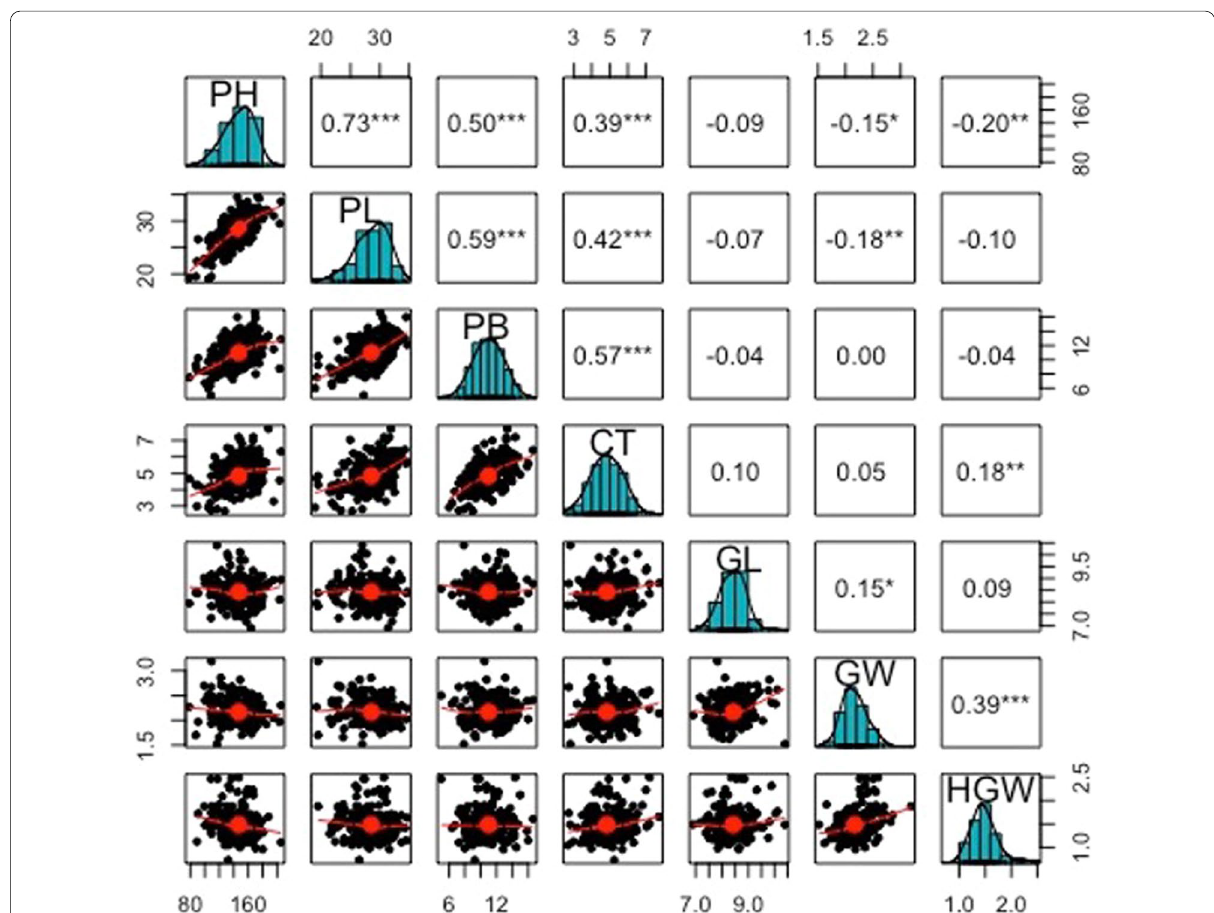
Fig. 1 Correlogram showing the distribution of phenotypic data for various traits and pairwise correlations between various traits. PH, PL and PB showed a negative correlation with GL, GW and HGW